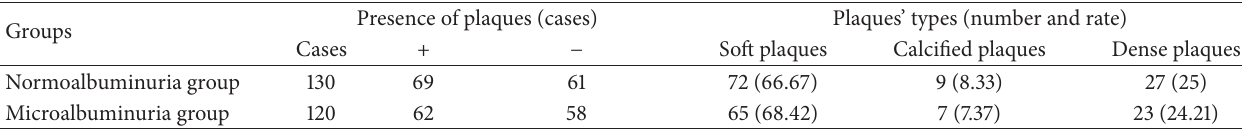
Table 2: Comparisons of plaques’ types and rates of two groups.